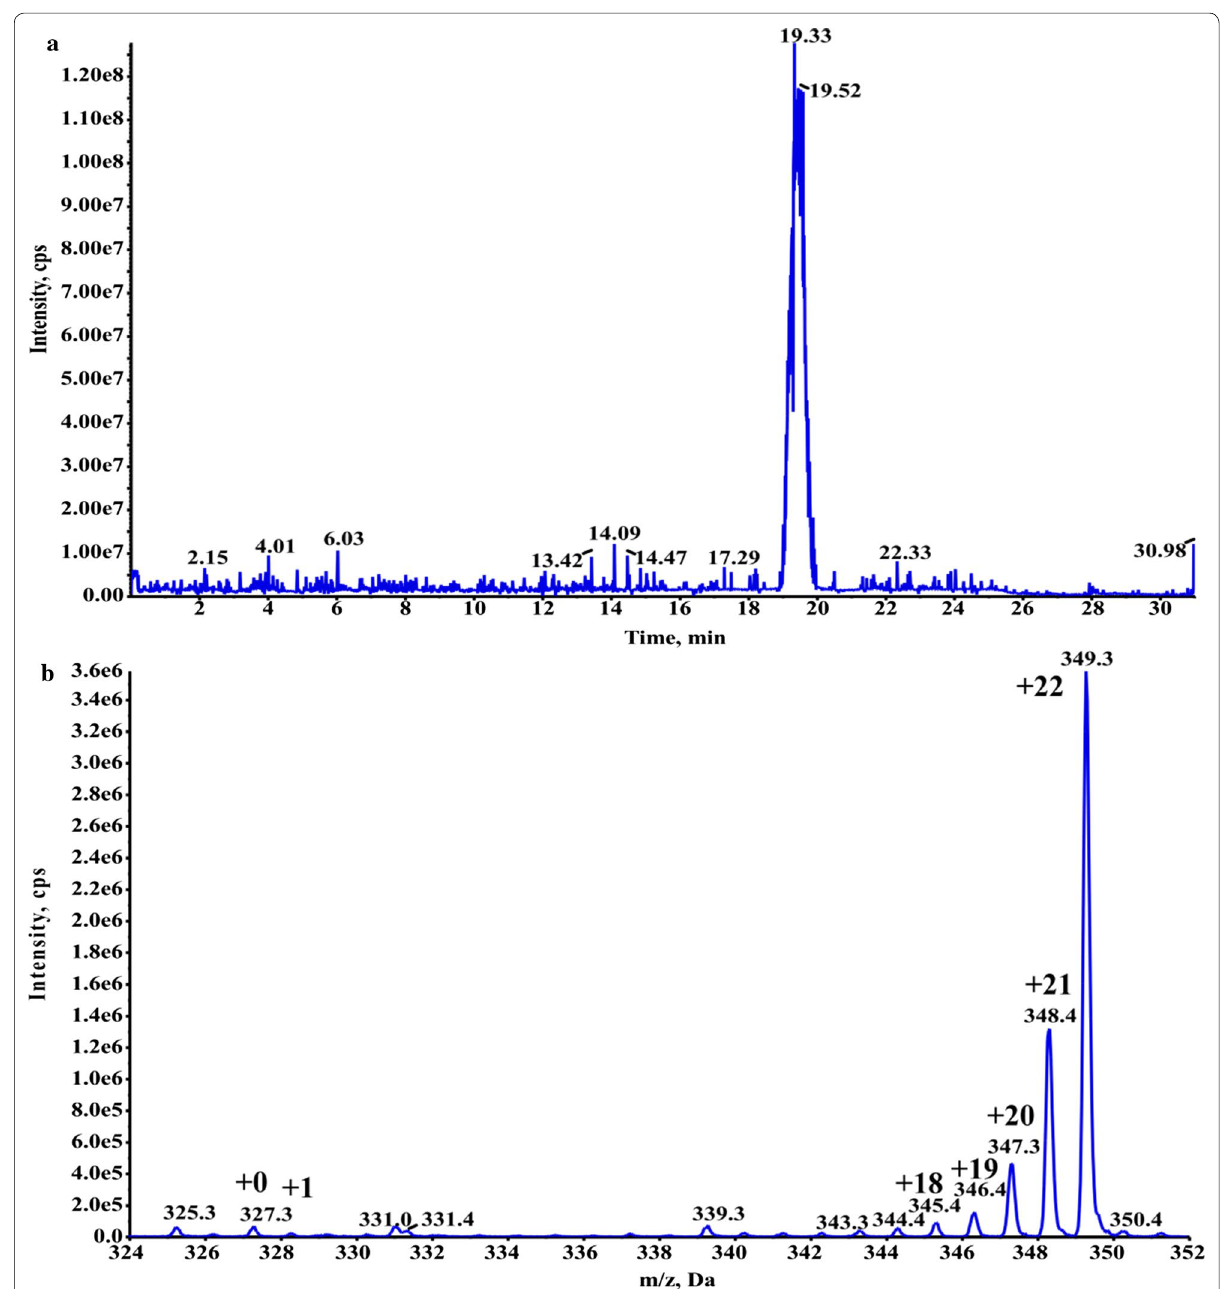
Fig. 2 The mass spectrums of purified U- 13 C-DHA from C. cohnii in the EMS mode. a Total ion current of the lipid extracts collected from HPLC fractions between 24–27 min for m/z 324–352; b unlabeled and labeled 13 =